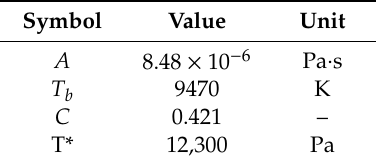
Table 3. Parameters of the Cross model.